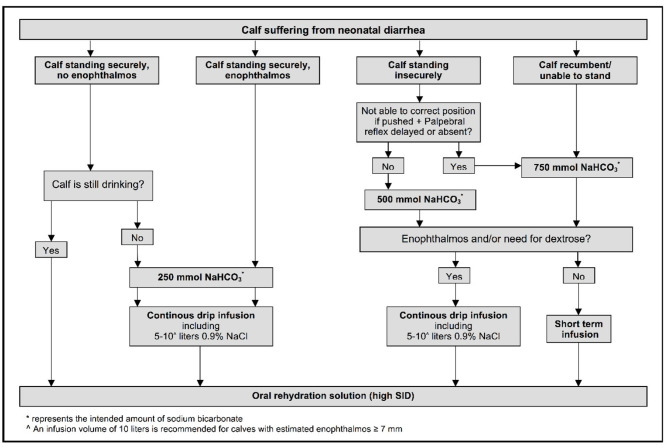
Decision tree for treating neonatal calves with diarrhea. The ability to stand is evaluated by lifting recumbent calves. Enophthalmos reflects a visible gap of 3–4 mm between the corneal surface of the eye and normal position of the lower eyelid. Reprinted with permission from: Trefz et al. (47).